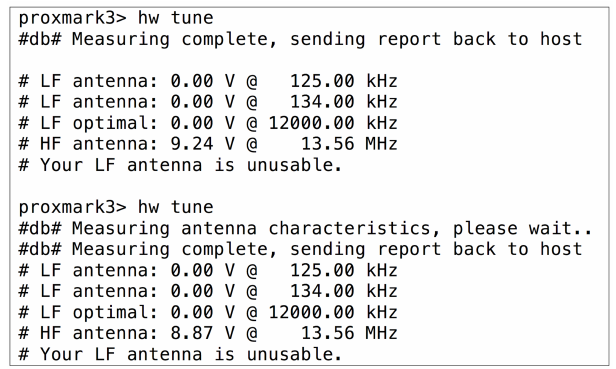
Figure 5. HF voltages for an LF tag when is present (second command) or not in the field.